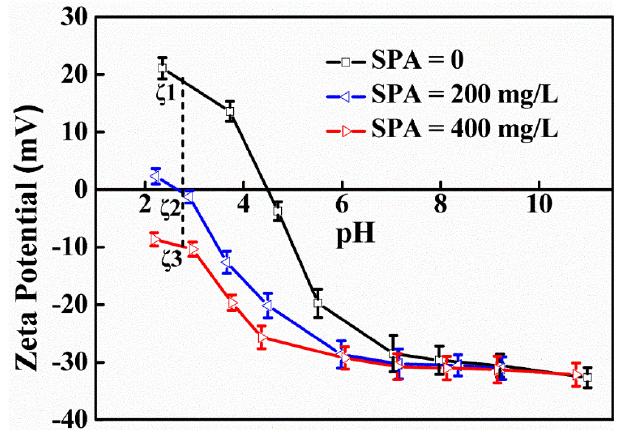
Figure 2. Zeta potential of TiO 2 as a function of pH and total SPA concentration in 10 − 3 mol/L KCl solution.